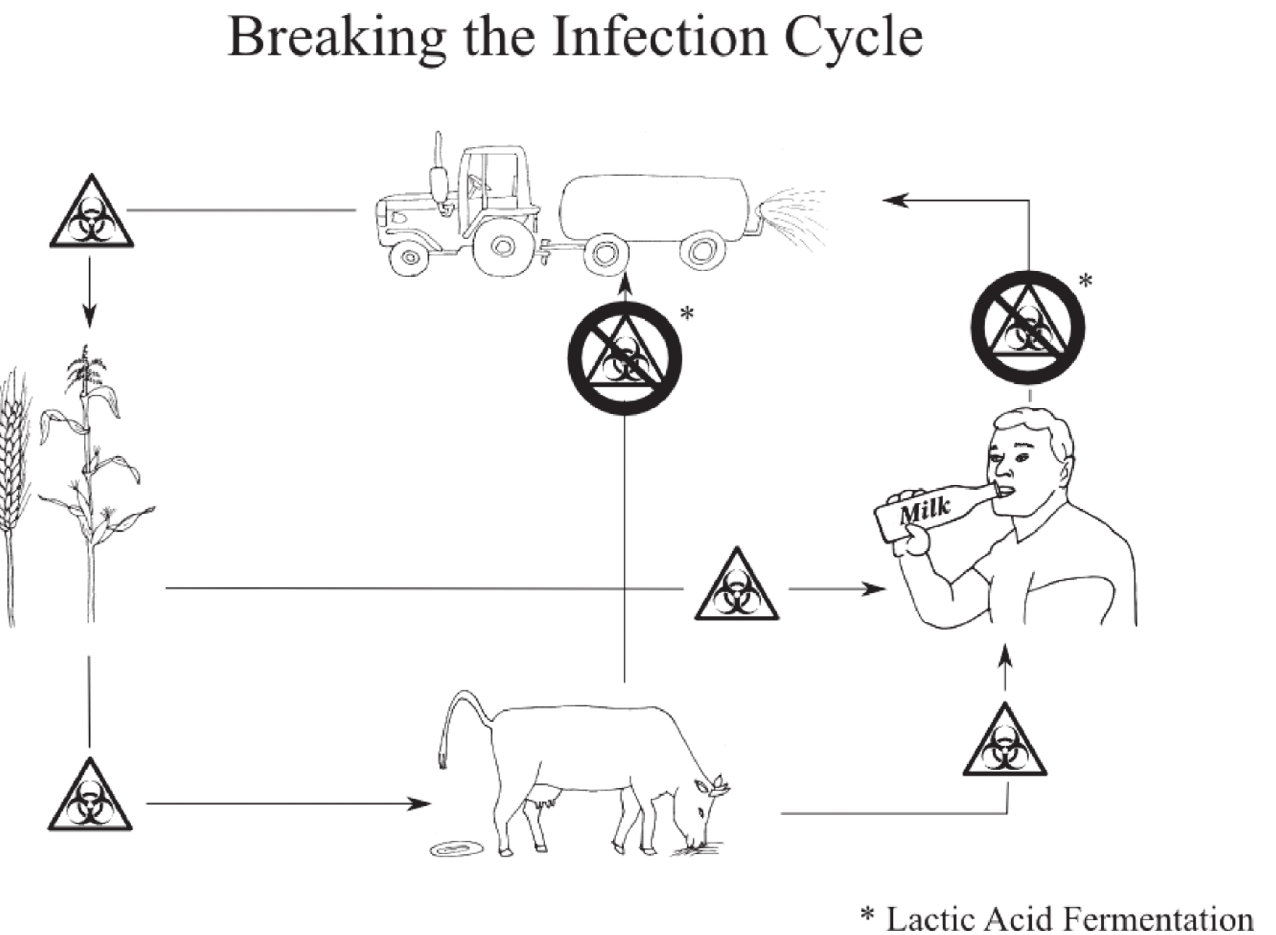
Fig 1. Graphical